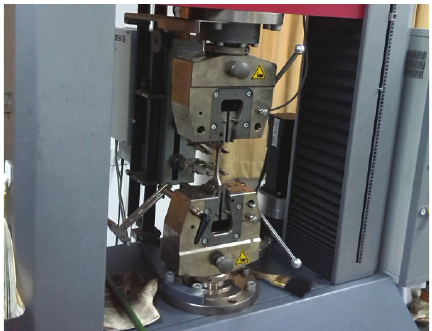
Figure 3: Stretching testing machine.